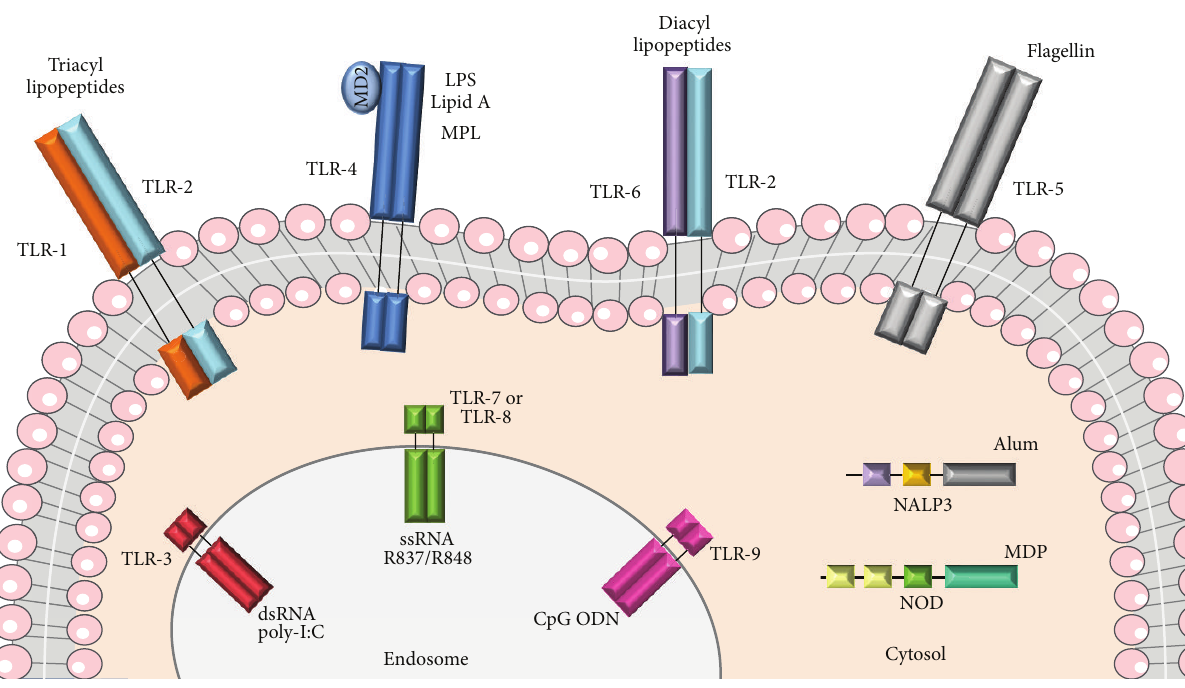
Figure 2: Adjuvants activate different immune innate receptors. TLRs (Toll-like receptors) and NLRs (NOD-like receptors).